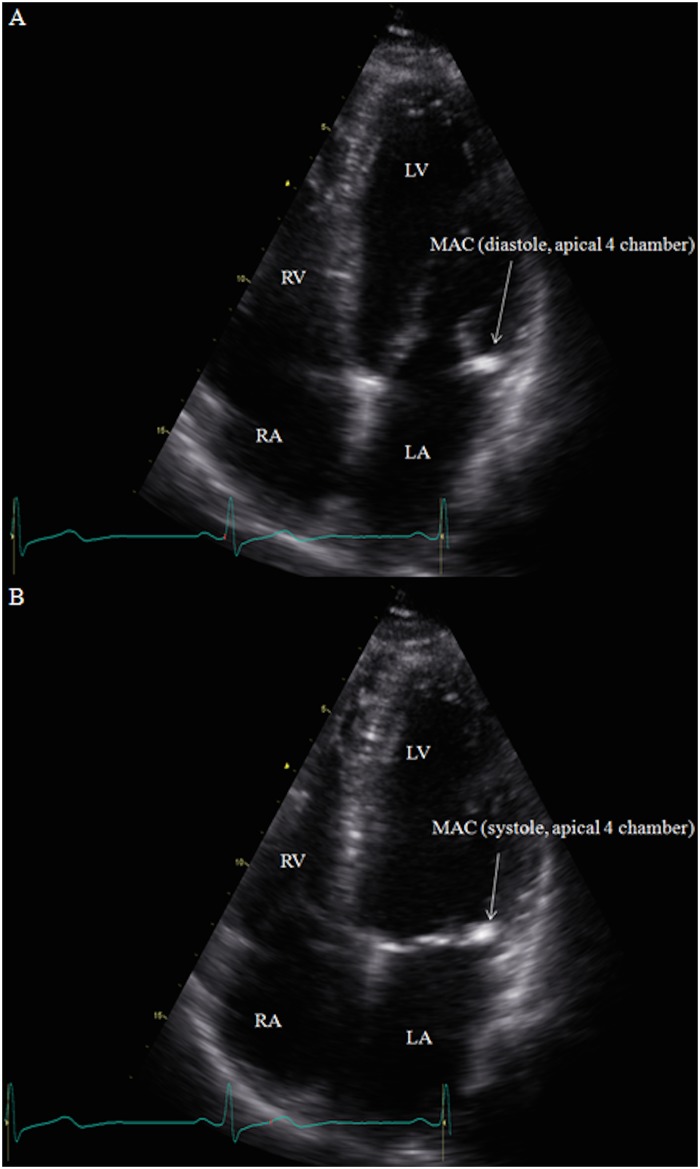
(A-B): MAC was defined as an echodense area visualized throughout systole and diastole, distinguishable from the posterior mitral valve leaflet, located anterior and parallel to the posterior left ventricular wall, seen here in the apical four chamber view during diastole (A) and systole (B).Abbreviations: Right Ventricle (RV), Left Ventricle (LV), Mitral Annular Calcification (MAC), Left Atrium (LA), Right Atrium (RA).